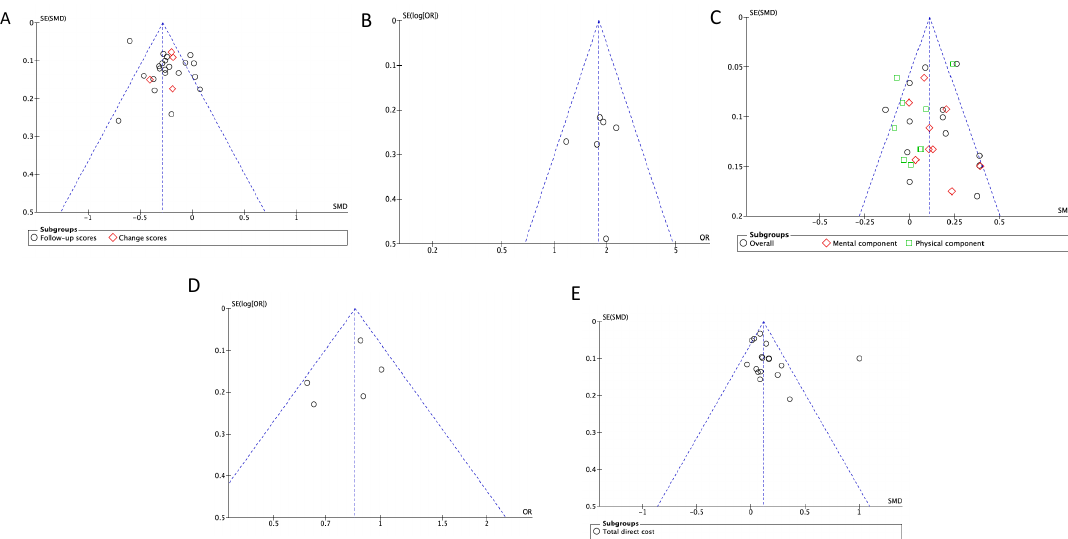
Figure 11. Funnel plots assessing asymmetry of depression, QoL, hospital admissions, and cost outcomes between the PCMH care and Standard GP care. ( A )—Depression (SMD); ( B )—Depression (OR); ( C )—Quality of Life (SMD); ( D )—Hospital admissions (OR); ( E )—Direct costs.